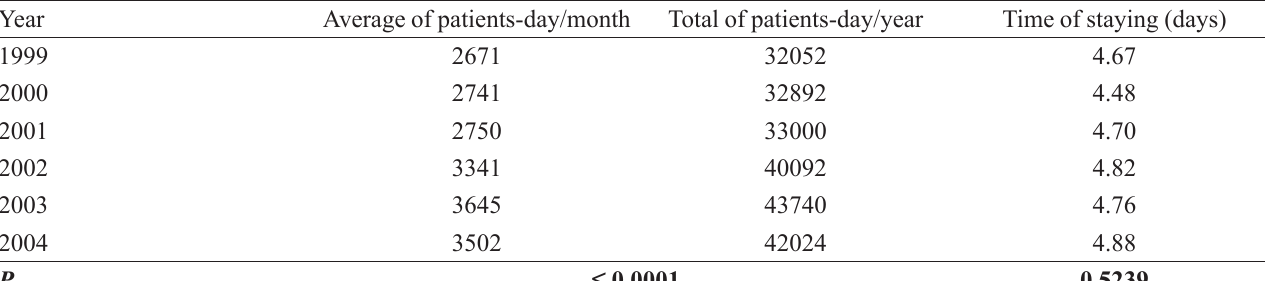
TABLE I – Number of attended patients-day and yearly average of staying at University Hospital of Western Paraná Year Average of patients-day/month Total of